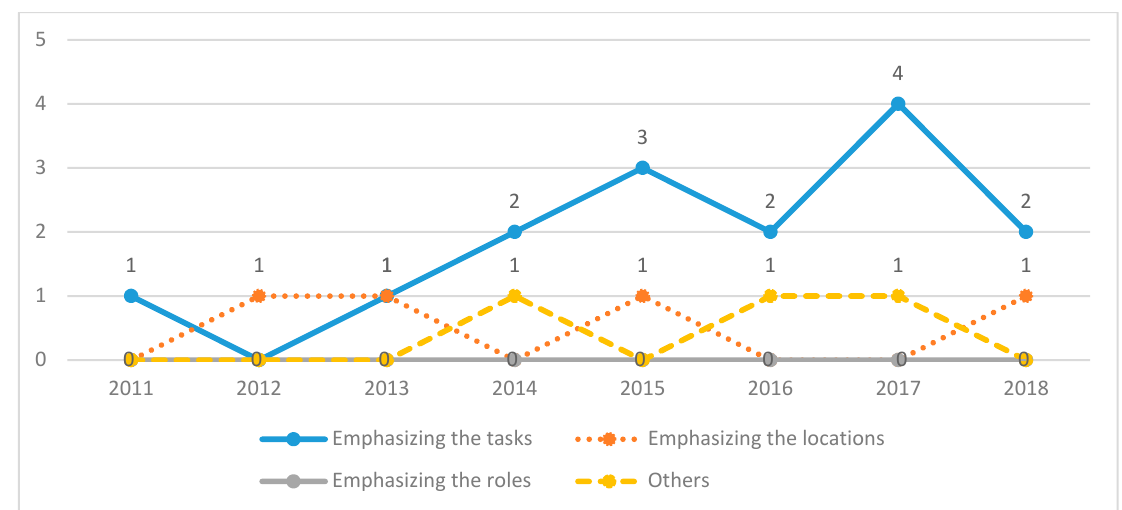
Figure 8. The number of studies for each teaching method.